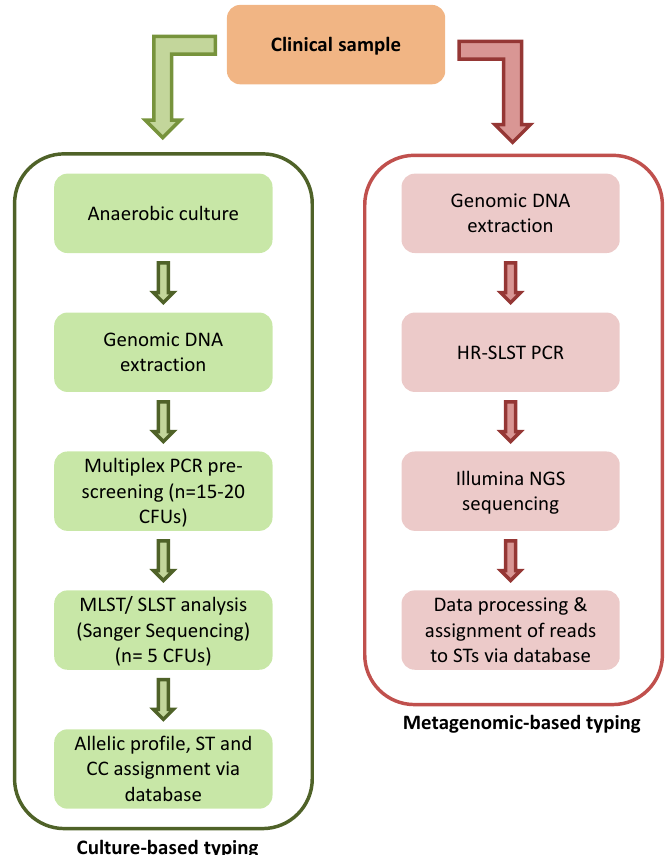
Figure 8. Algorithm for culture and non-culture-based typing pathways for P. acnes